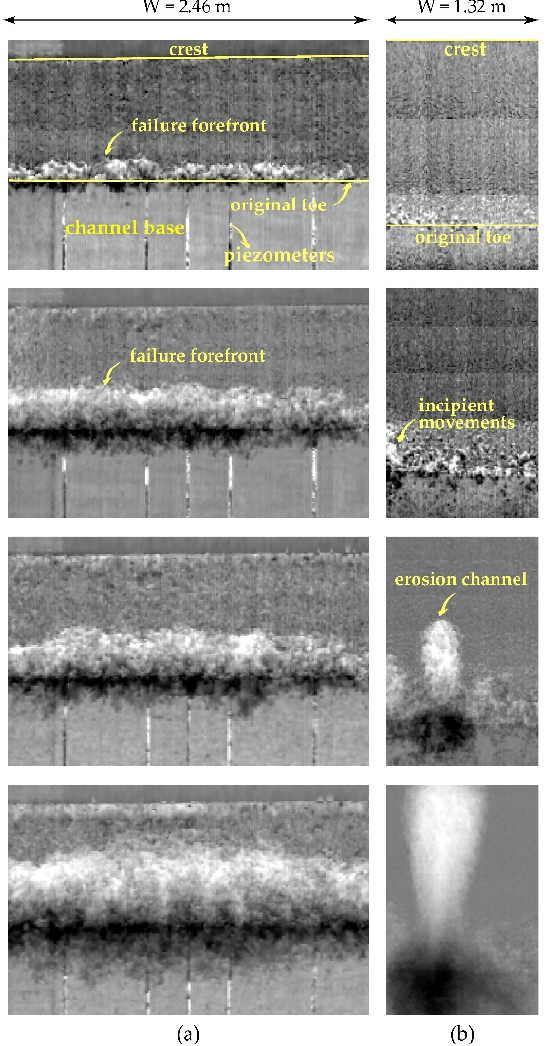
Figure 7. Two dominant mechanisms of failure: ( a ) mass sliding and ( b ) particle dragging.